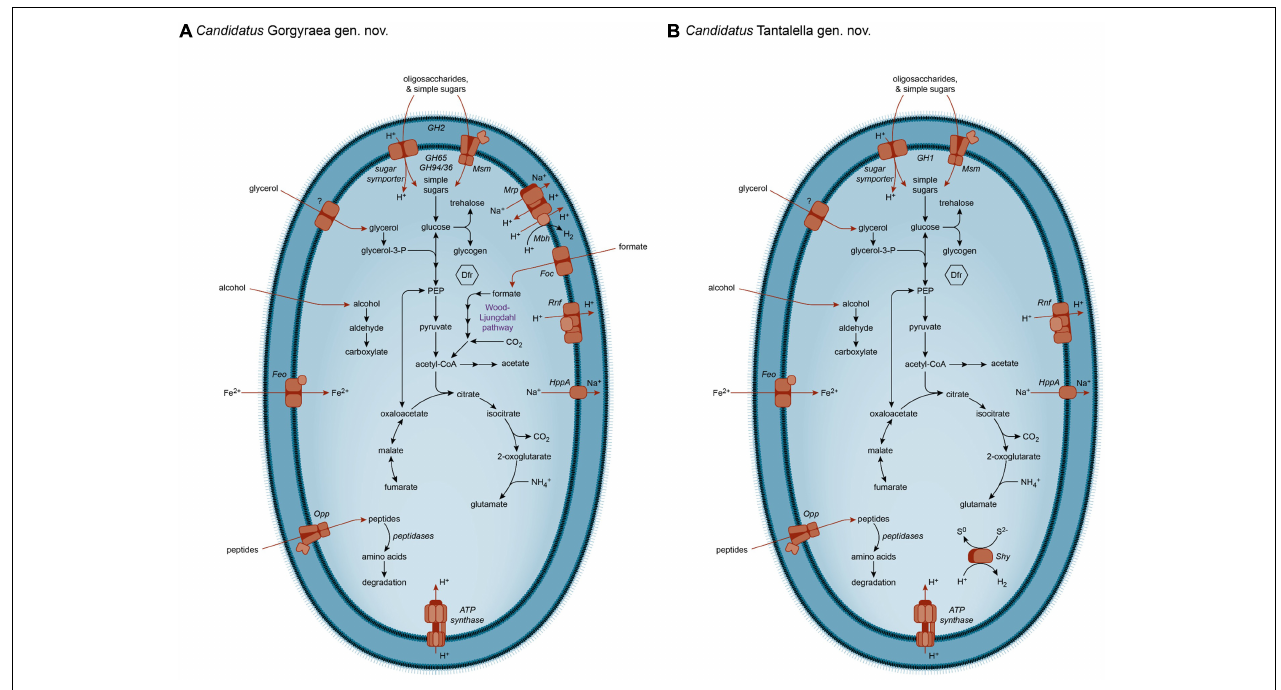
FIGURE 4 | Metabolic capacity of Omnitrophota. Metabolic capacities inferred from MAGs for (A) Candidatus Gorgyraea and (B) Candidatus Tantalella. ABC, ATP-binding cassette transport system; Dfr, desulfoferrodoxin; Feo, ferrous iron transporter; Foc, formate transporter; GH, glycoside hydrolase; HppA, pyrophosphate-energized sodium pump; Mbh, membrane-bound [NiFe] hydrogenase; Mrp, multicomponent Na + :H + antiporter; Msm, multiple sugar ABC transporter; Opp, oligopeptide ABC transporter; PEP, phosphoenolpyruvate; Rnf, ferredoxin:NAD + -oxidoreductase complex; Shy,